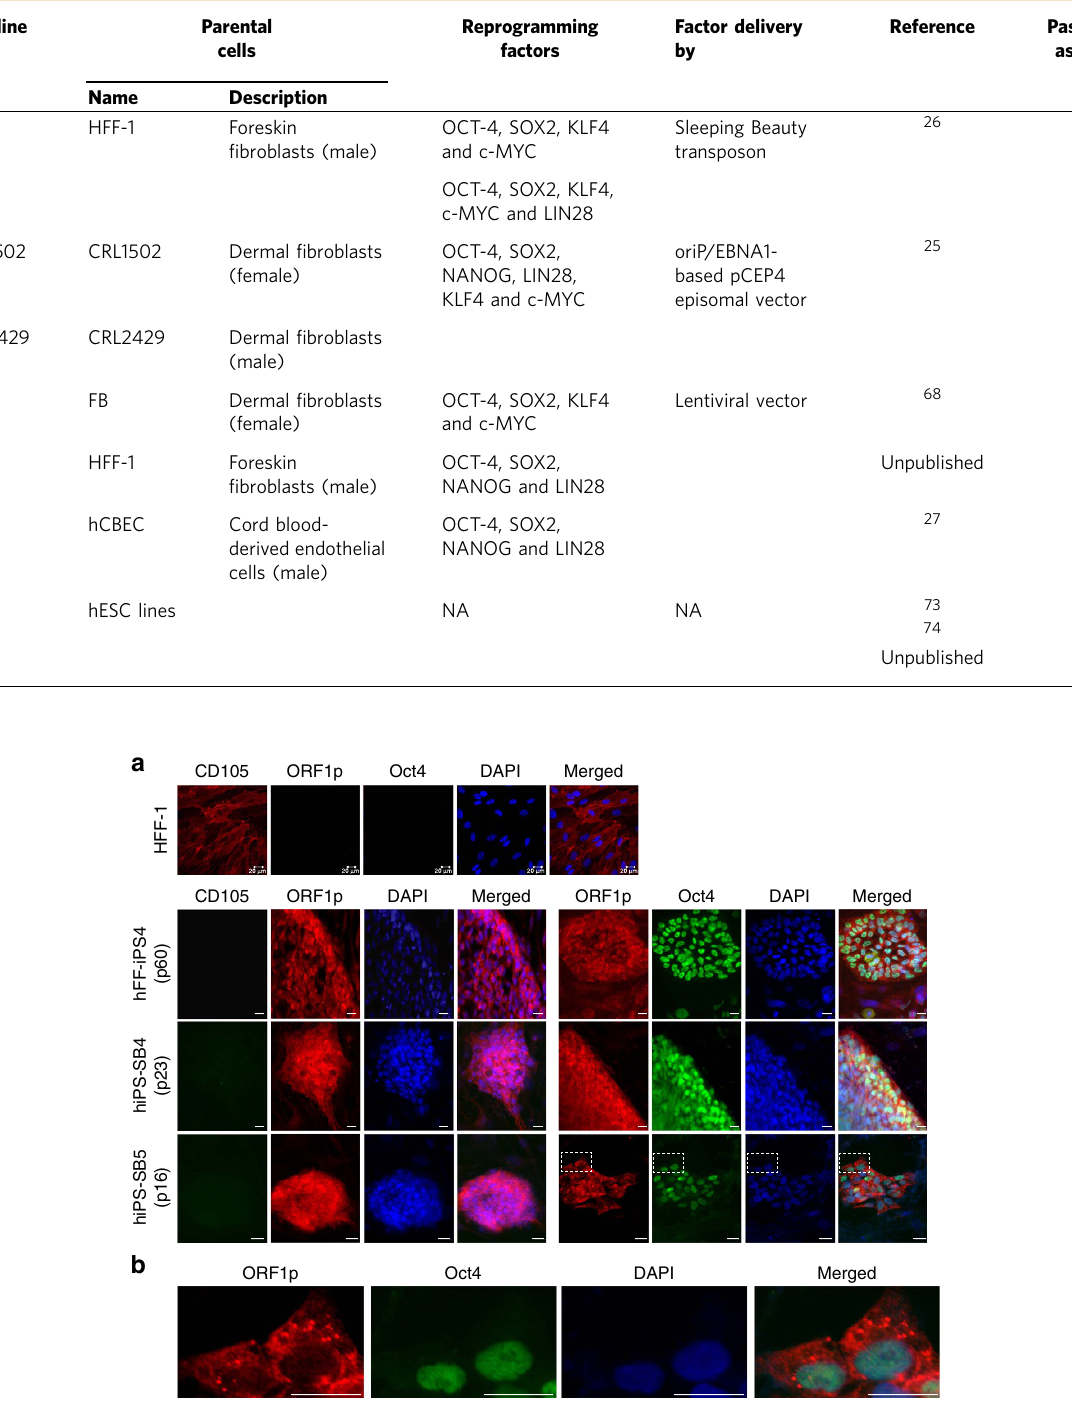
Figure 2 | Immunofluorescence staining of hiPSC colonies and their parental cells for endogenous L1 ORF1p expression in HFF-1-derived hiPSCs. ( a ) ORF1p staining indicates activation of endogenous L1 expression after reprogramming of HFF-1 cells into lines hiPS-SB4, hiPS-SB5 and hFF-iPS4. Cells were analysed at passages (p) 23, 16 and 60, respectively. Oct-3/4 staining confirmed the pluripotent status of the analysed stem cell colonies. Mesenchymal stem cell marker CD105 (endoglin) is reported to be expressed in HFF-1 cells but not expressed in pluripotent stem cells. ( b ) Enlarged areas indicated by boxed dashes in a demonstrate cytoplasmic localization of endogenous L1 ORF1p and its accumulation in foci. Scale bars, 20 m